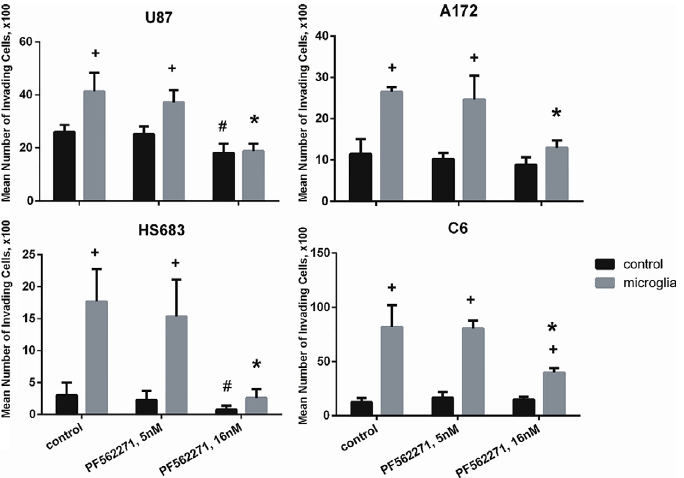
Fig 6. FAK is not involved in microglial stimulation of migration in glioma cells. Data obtained from migration assays for glioma cells. Cells were treated with 5nM (concentration that effectively blocks FAK) and 16nM (concentration that effectively blocks Pyk2) of PF-562,271. Due to different migration abilities in all presented cell lines the Y-axis scales are adjusted for each cell line in order to demonstrate the absolute numbers of migrating cells. Results are presented as mean ± S.D. with significant differences from control in each group (+), from Mock without microglia on the bottom (#), or from Mock with microglia on the bottom ( * ) (p < 0.05). One-way ANOVA followed by the Tukey ’ s multiple comparison test was used to determine significance between